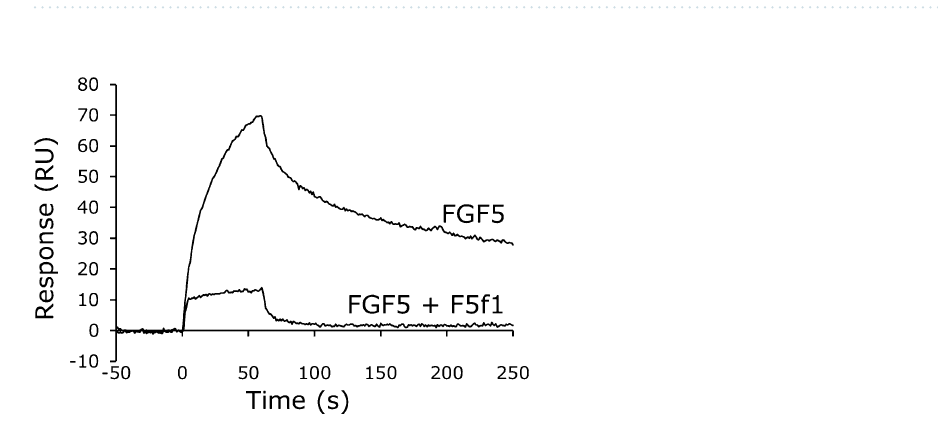
Figure 3. Specificity of F5f1 aptamer binding to FGF5. After immobilization of F5f1 aptamer on the sensor chip, 100 nM human FGF5, other human FGF family members, or extracellular domain of human FGFR1 was injected with four equivalents of low-molecular-weight heparin.